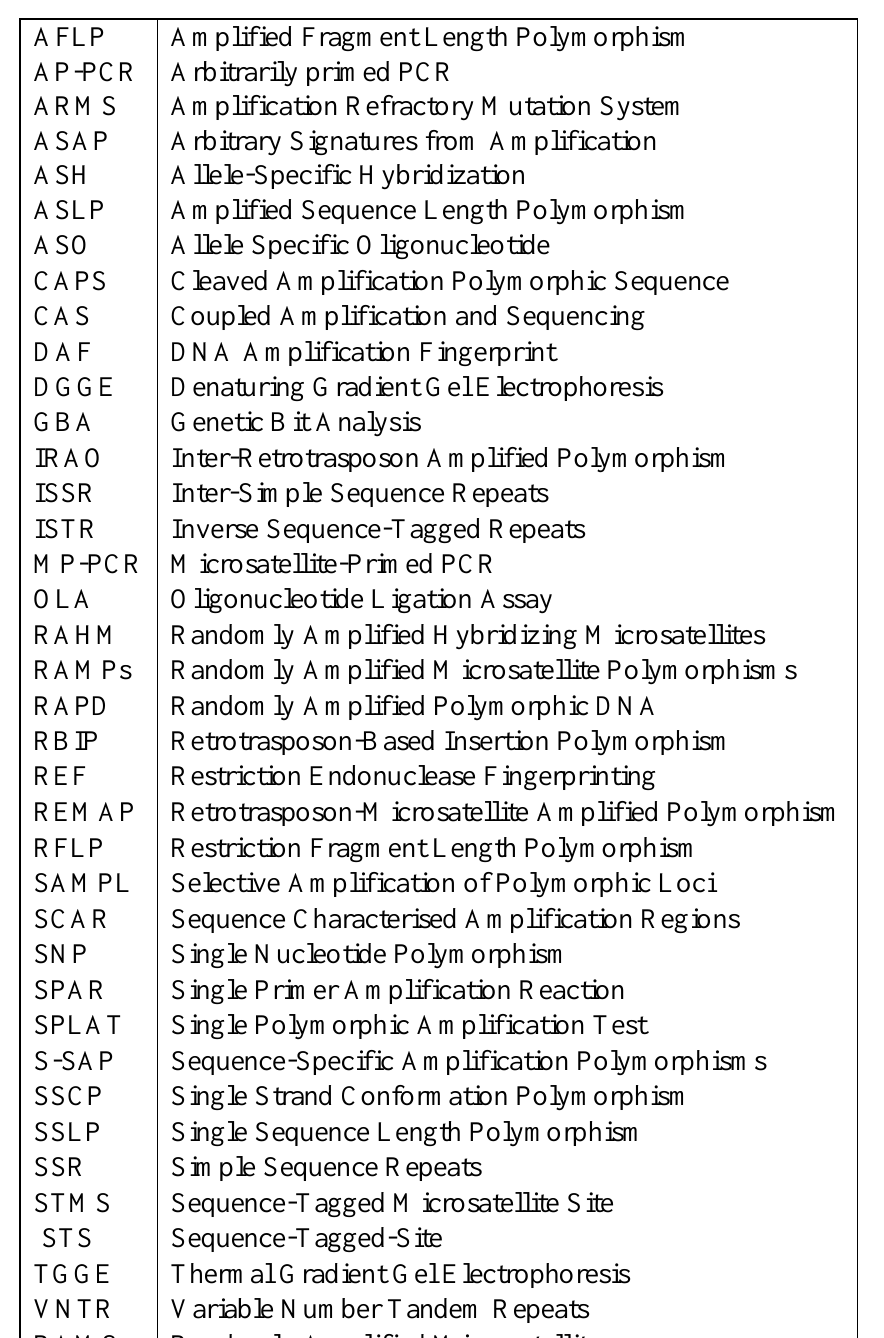
Table 1. Acronyms commonly used for different molecular